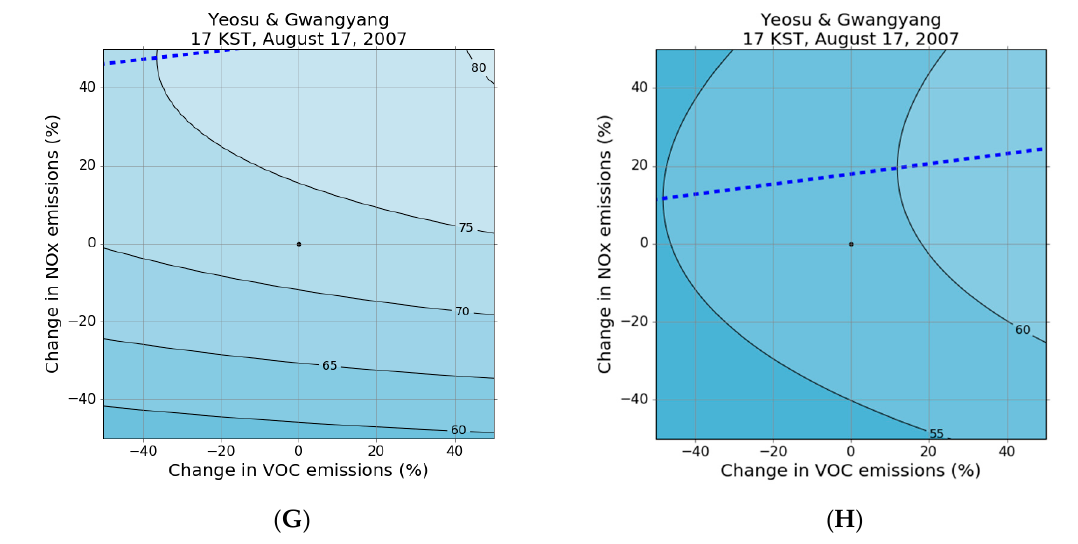
Figure 13. Ozone isopleth for major cities in the modeling domain at selected hours: ( A ) Gwangju with MEGAN, ( B ) Gwangju with BEIS3, ( C ) Tongyeong and Geoje with MEGAN, ( D ) Tongyeong and Geoje with BEIS3, ( E ) Jinju and Sacheon with MEGAN, ( F ) Jinju and Sacheon with BEIS3, ( G ) Yeosu and Gwangyang with MEGAN, and ( H ) Yeosu and Gwangyang with BEIS3. Dotted blue lines represent the ridgeline when (cid:2986)(cid:4670)(cid:2899) (cid:3119) (cid:4671) = 0 at given NO x emission, ENO x . The arrows in ( F ) illustrate ozone concentration changes with NO x emission reductions from 0% to 10% or 20%.